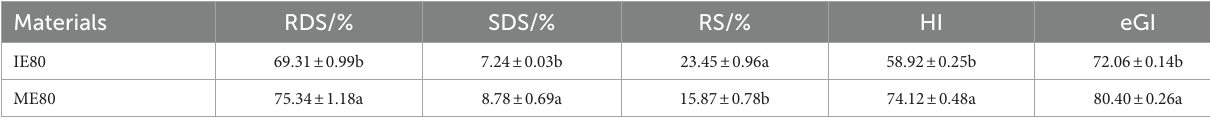
TABLE 5 The starch fractions, HI and eGI of different instant powder samples.